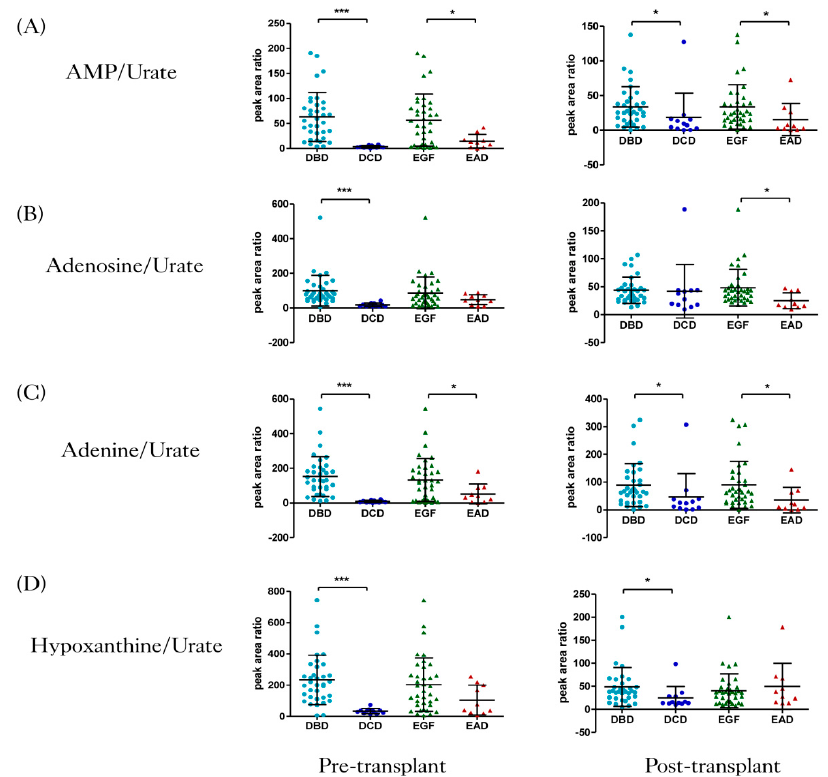
Figure 1. Jittered scatter plots of four ratios of metabolites’ levels in four groups at two transplant stages. ( A ) Adenosine monophosphate (AMP)/urate, ( B ) adenosine/urate, ( C ) adenine/urate, and ( D )